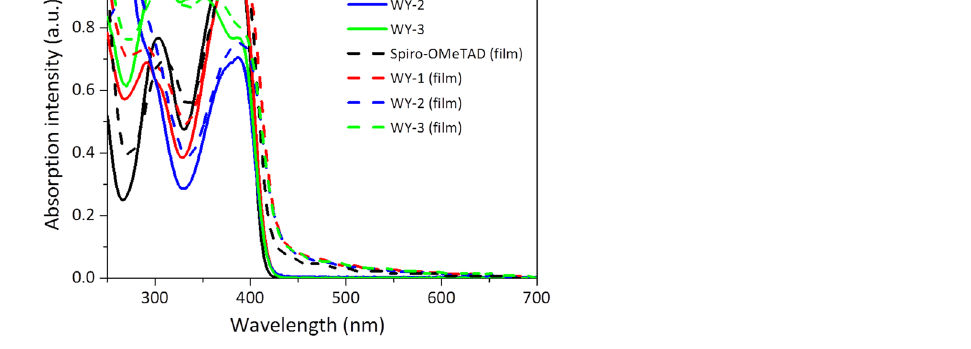
Figure 2. UV-vis absorption spectra of four HTMs measured in solutions (solid line) and thin films (dash